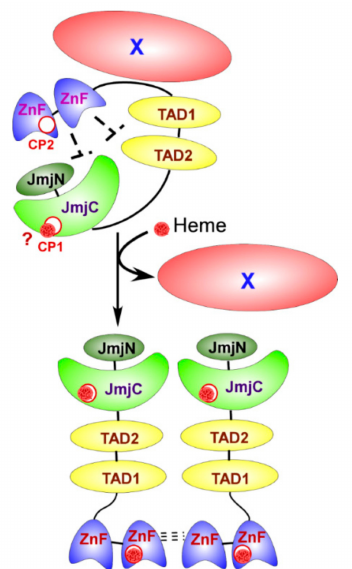
Figure 2. At low heme levels, the ZnF region and other proteins (X) repress Gis1 transcriptional and demethylase activities. At higher heme concentrations, heme binds a second site in the ZnF causing loss of X, oligomerization of Gis1, and conformational changes which fully activate Gis1 demethylase and transcriptional activities. JmjN and JmjC: jumonji domains and demethylase activity. TAD1 and TAD2: transcription activation domains. ZnF: C2H2 type zinc